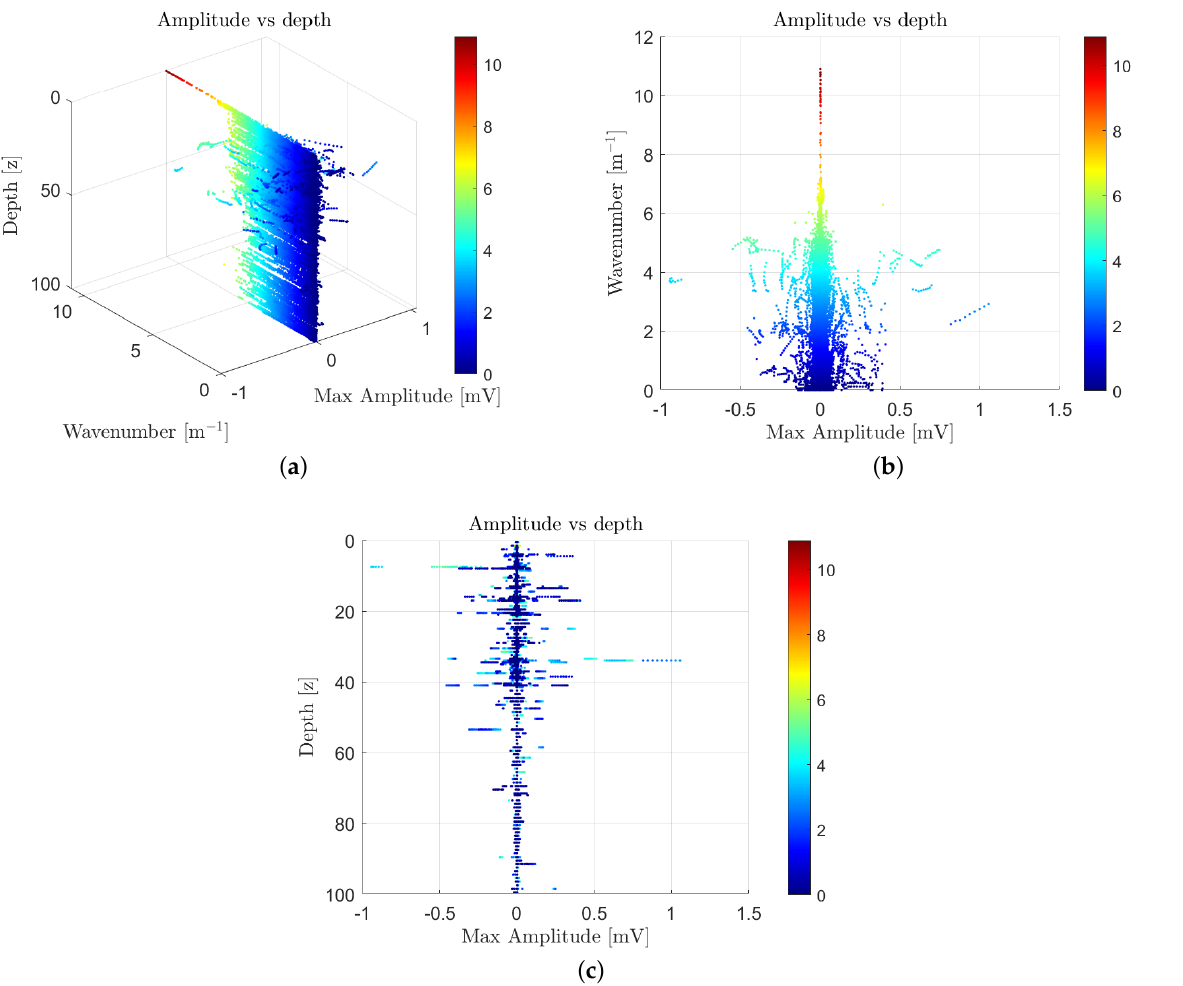
Figure 7. 3-D dispersion curves where the phase velocity is function of the signal amplitude in [mV], the wavenumber [m − 1 ] and the depth [m]. The three images ( a – c ) are different views of the same scatter